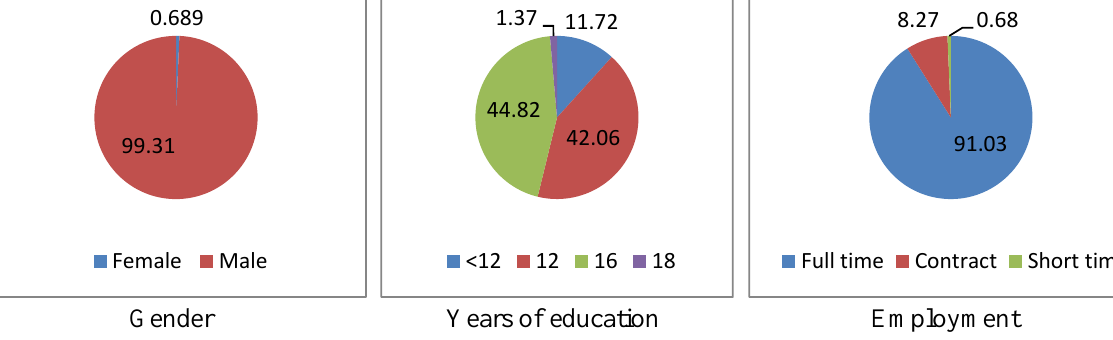
Fig. 1. Personal charactersitics of the